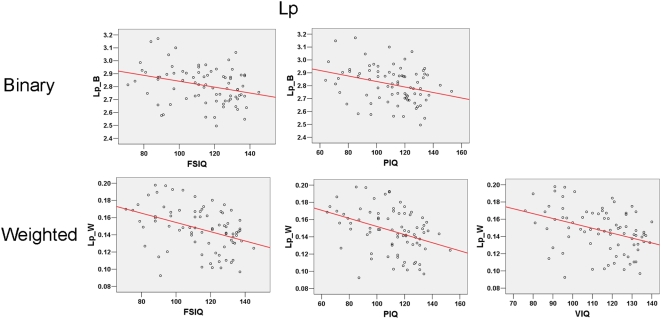
Significant partial correlation between Lp and intelligence tests scores.In the case of binary networks,  was found to be negatively correlated to FSIQ and PIQ; and in the case of weighted networks,  was found to be negatively correlated to FSIQ, PIQ and VIQ.